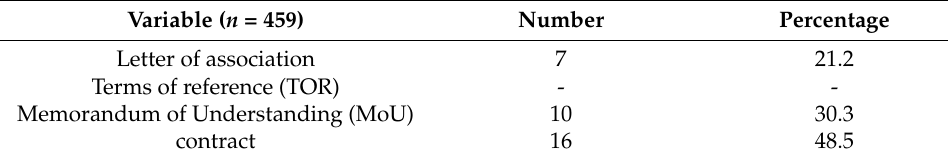
Table 5. The legal form applied by the partnerships investigated.